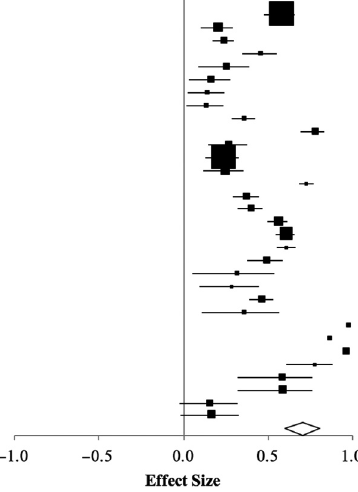
Figure 2. Forest plot